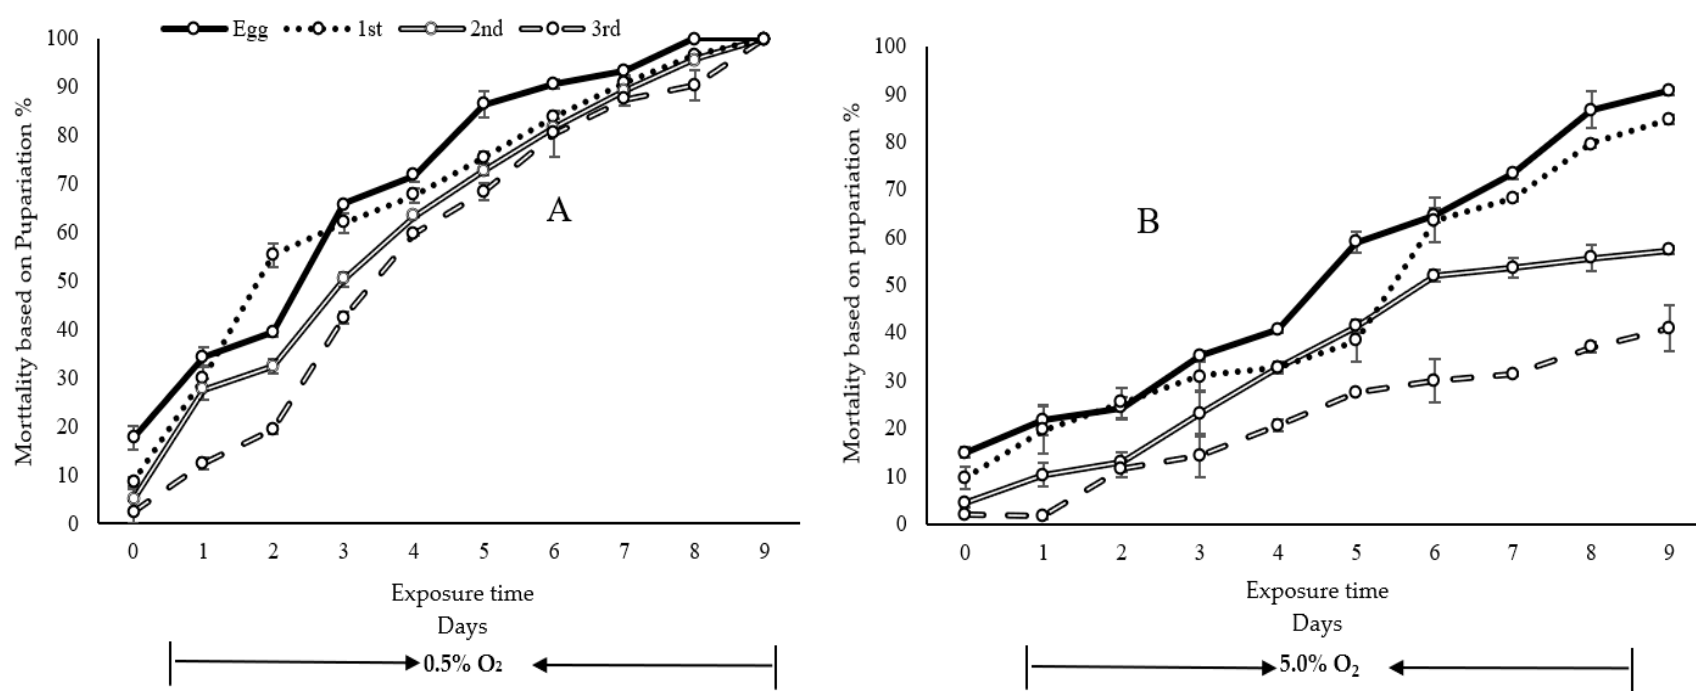
Figure 2. Mortality (SE) of eggs and 1st, 2nd and 3rd stage larvae based on pupariation rate. ( A )—0.5% O 2 and ( B )—5.0% O 2.